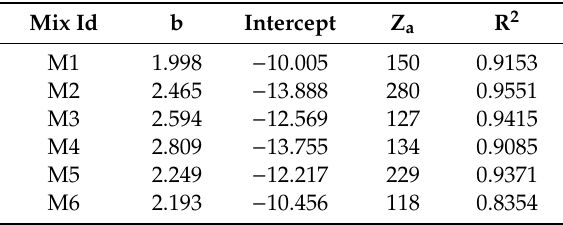
Table 4. Computed Weibull